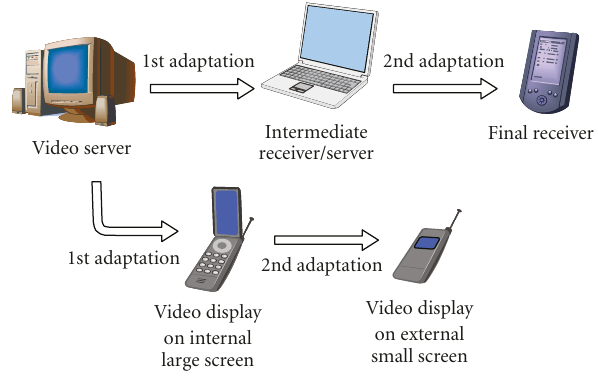
Figure 1: Two examples of multiple-adaptation applications where the same video content is adapted several times down the distribu- tion